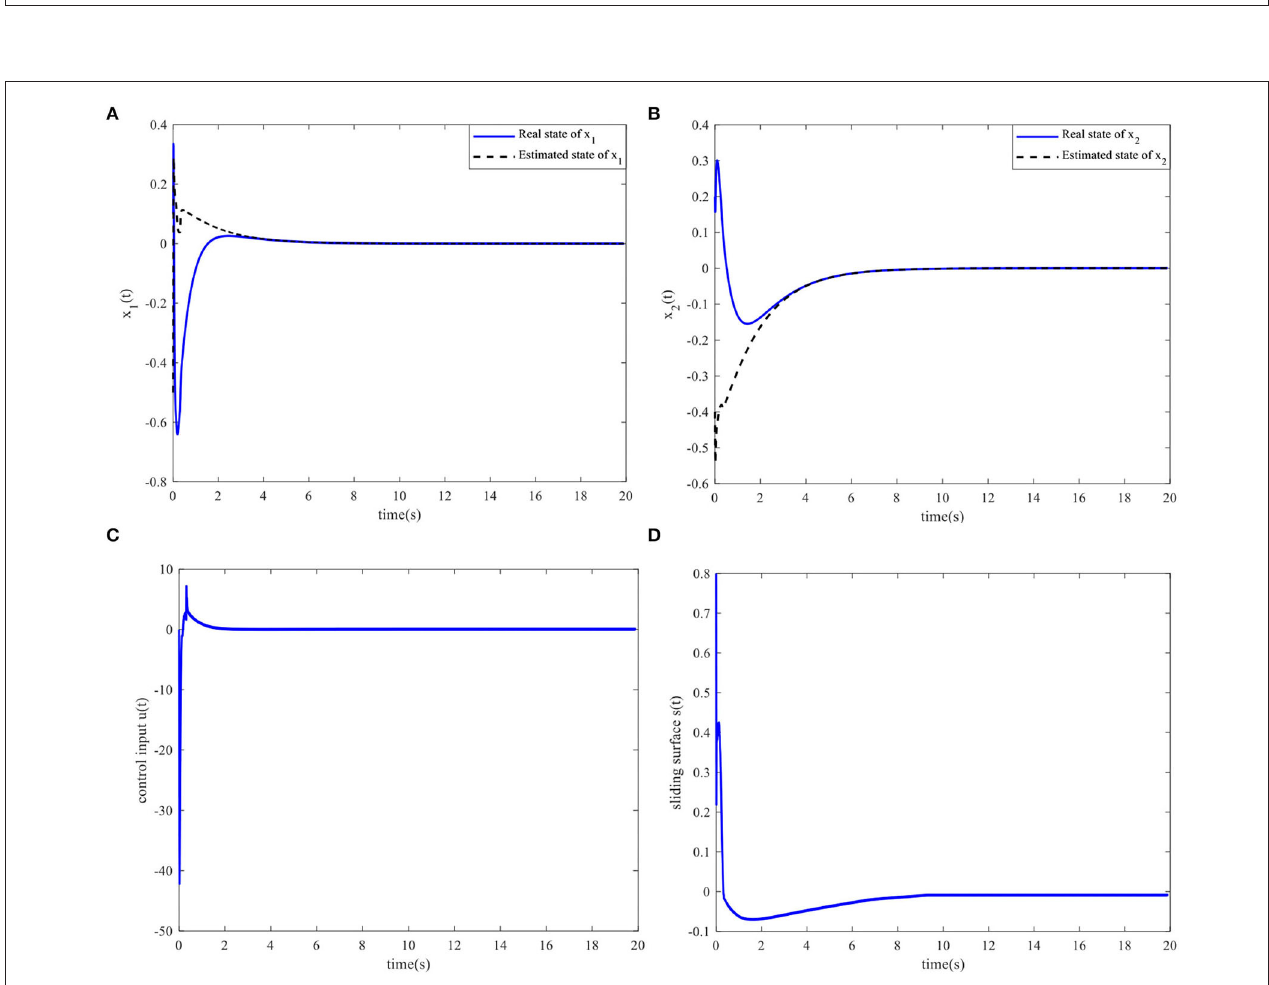
FIGURE 3 | Time responses of the system. (A) State x 1 ( t ) and the estimated ˆ x 1 ( t ). (B) State x 2 ( t ) and the estimated ˆ x 2 ( t ). (C) Control input. (D) Sliding surface.